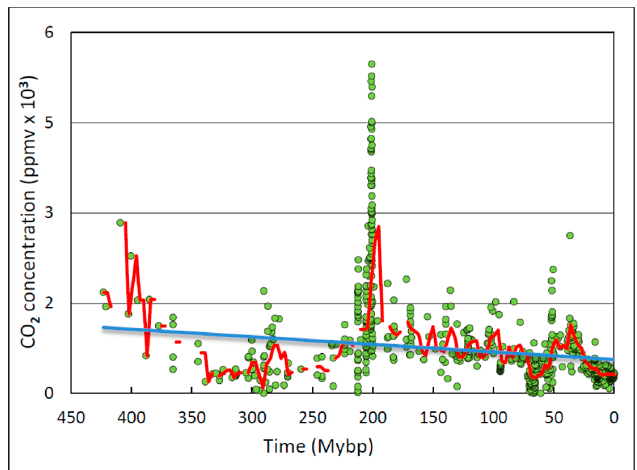
Figure 4. Atmospheric carbon dioxide (CO 2 ) concentration proxies over the Phanerozoic Eon. Original raw data (green datapoints, n = 831) are from the database compiled by Royer [40]. The fitted red curve was computed as a 3–6 My moving average.